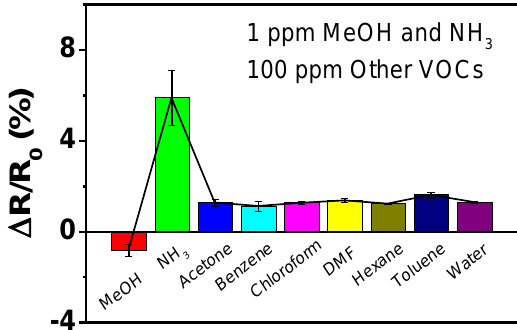
Figure 9. Normalized resistance changes of the electrodes with periodic exposure to 0.1 ppm of NH 3 for 15 days (black: pH 1; red: pH 7; blue: pH 13).